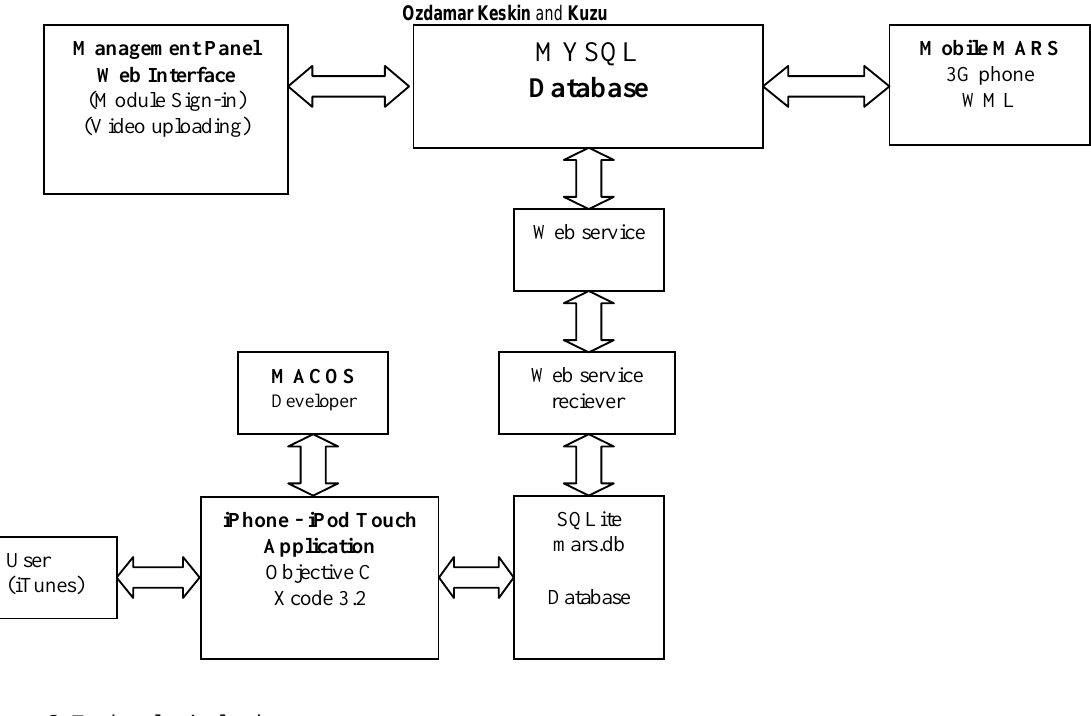
Figure 3 . Technological